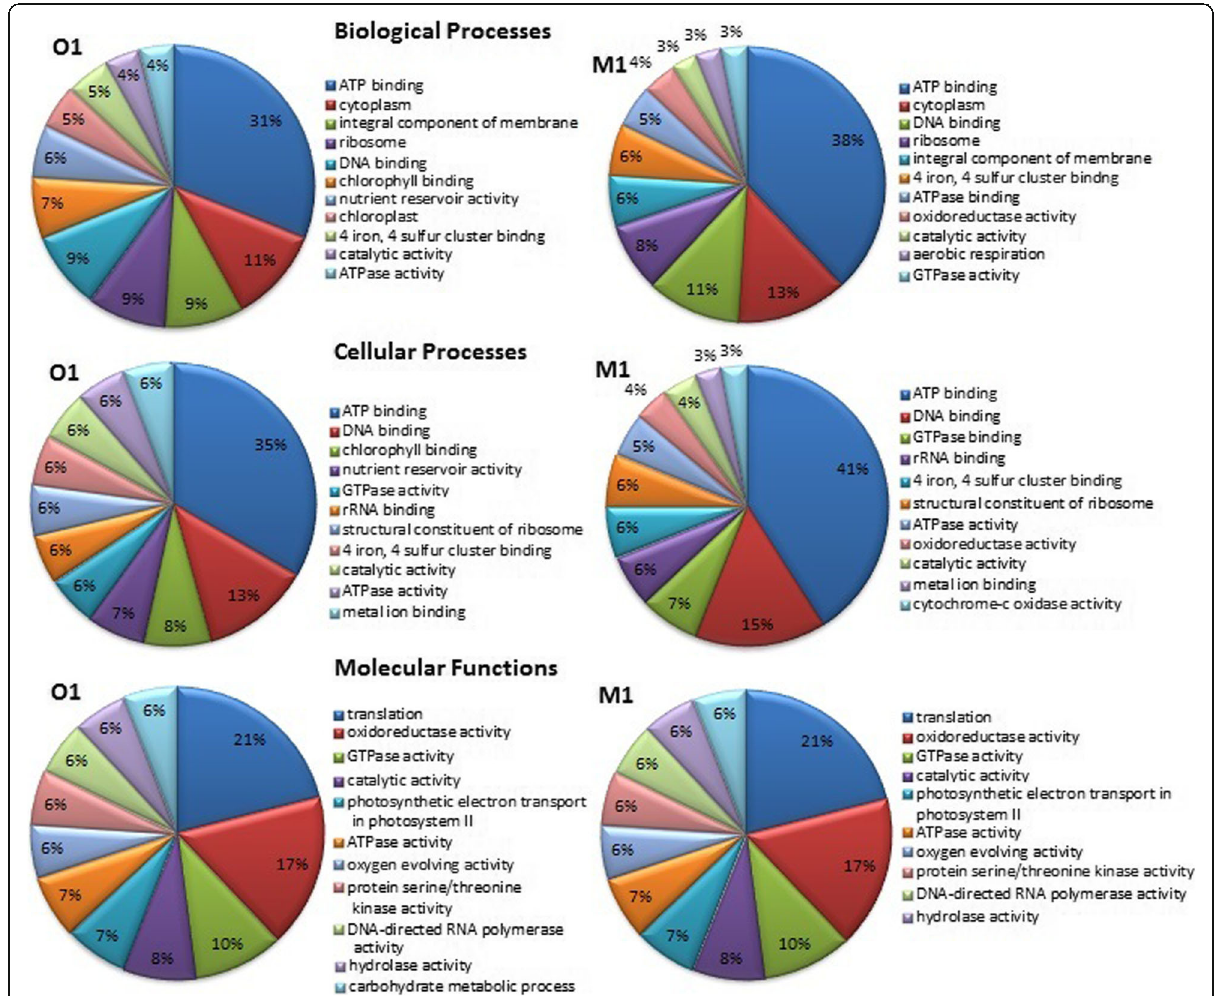
Fig. 1 Percent distribution of transcripts assigned to biological processes, molecular functions, and cellular components mapped using Gene